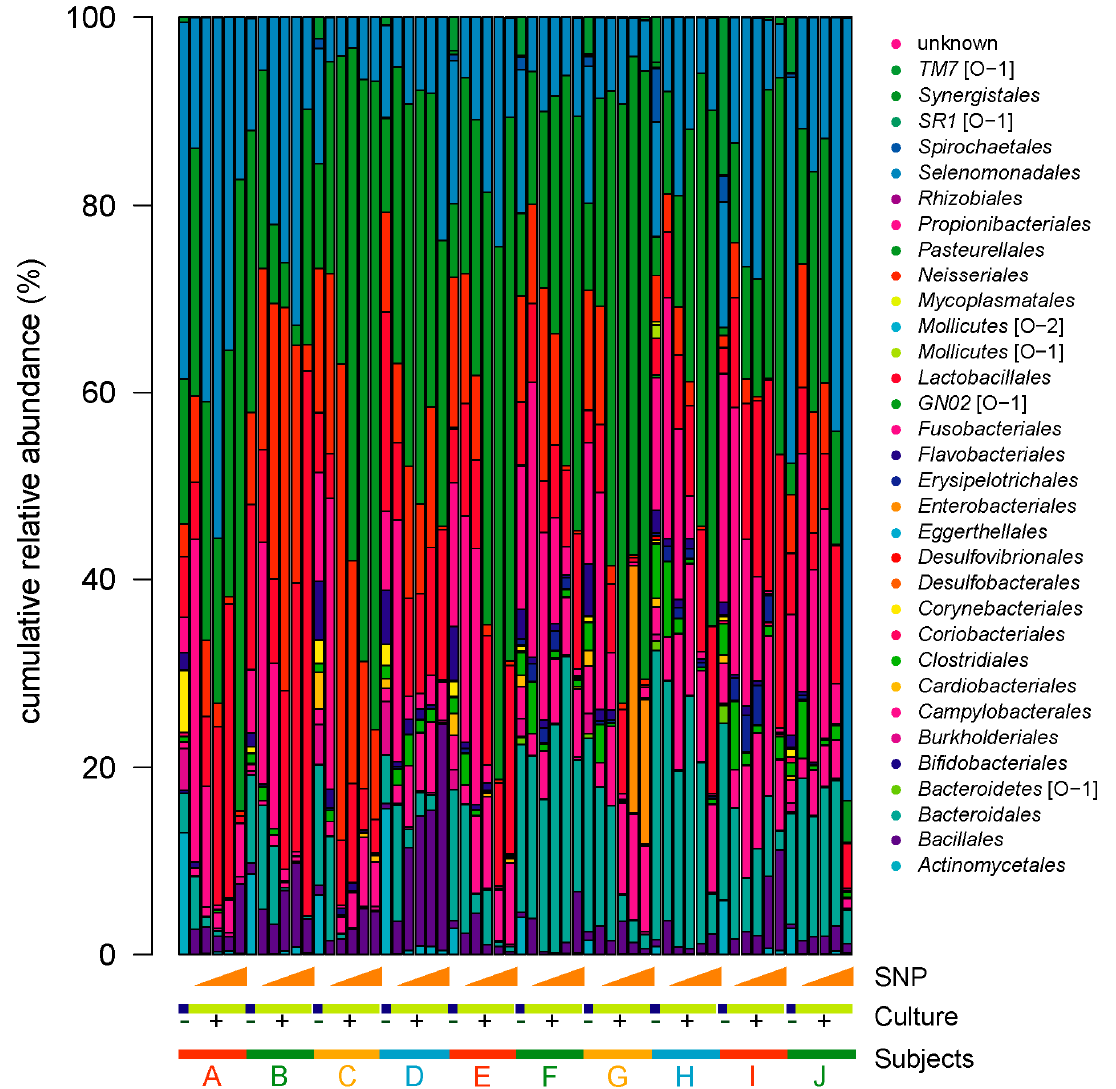
Figure 2. Bacterial community shift under sodium nitroprusside (SNP) exposure and in vitro culture. Stacked bar charts show taxonomic distribution at the order level. Each bar represents a single sample, with each color representing different bacterial taxa; sorted by individuals. The detailed information for each operational taxonomic unit (OTU) can be found in Table S2.